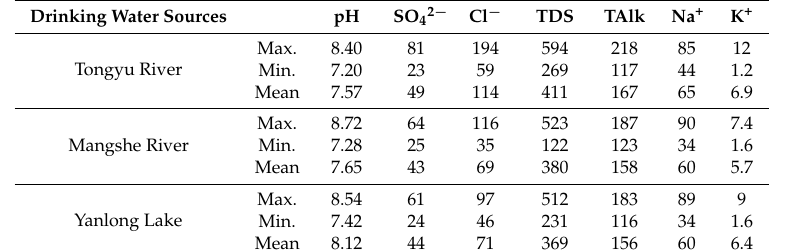
Table 2. Other physicochemical parameters in three drinking water sources of Yancheng City.